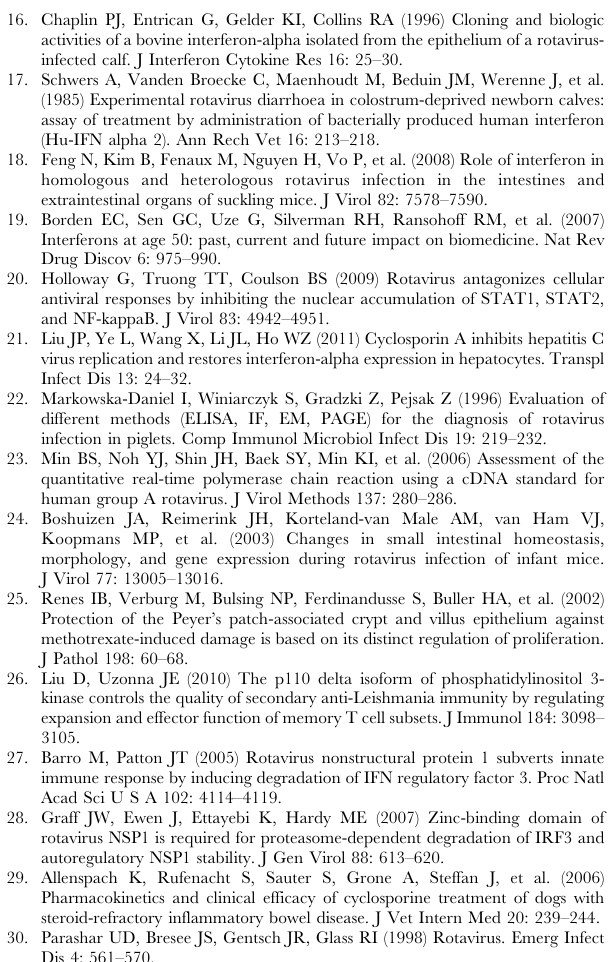
Table S1 Primes used for real-time reverse-transcrip- tion polymerase chain reaction assay. Table S2 Villi height and crypts depth of jejunum post treatments with different